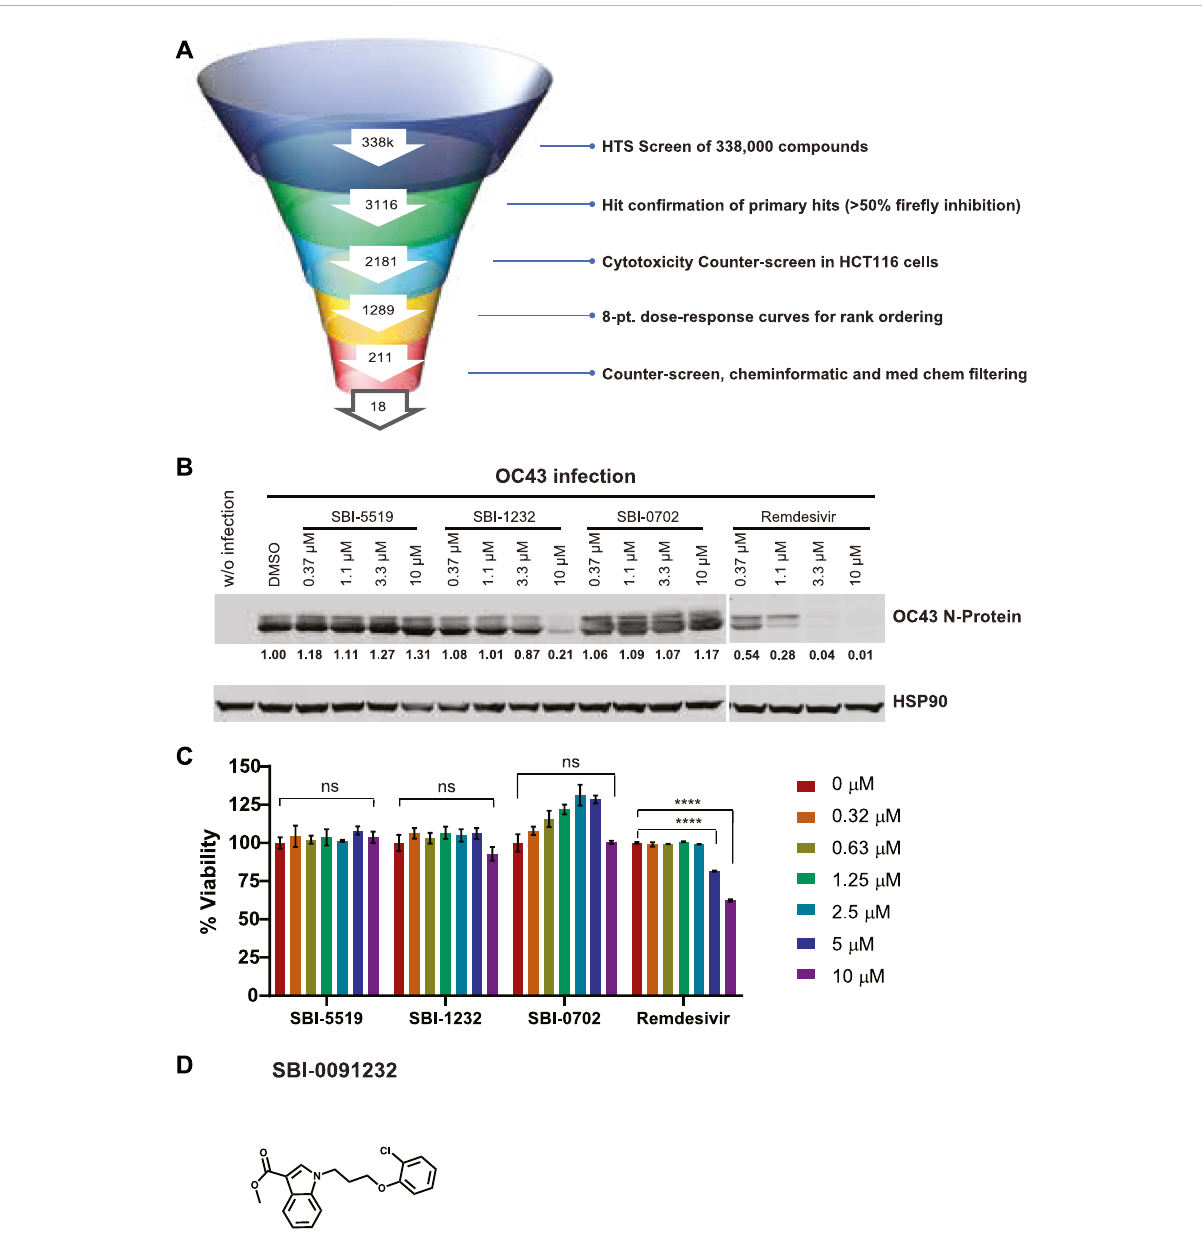
Identi fi cation and validation of OC43 N-protein expression inhibitors. (A) Testing funnel of high-throughput screening campaign. HTS screen performed using fi re fl y (FF) luciferase readout in RRLs using 338,000 compounds. Hits (3116) were selected for CAP-dependent inhibition based on 50% inhibition of the fi re fl y readout, for CAP-dependent inhibition, and further assessed in a cytotoxicity counter-screen using HCT116 cells, excluding compounds promoting nonspeci fi c inhibition of Ren luciferase activity. The resulting 2,181 compounds were subjected to eight points dose-dependent inhibition assessments for effectiveness, which reduced the number of hits to 221. Counter-screens at 5 and 10 mM and additionalchemoinformaticandmedicinalchemistryassessmentledtoselectionof18compounds. (B) Westernblotanalysisofindicatedproteinsin A549 cells. Cells (2 x 105) were infected with OC43 and treated immediately following infection with indicated compounds and concentrations for 24 h. Each protein band was quanti fi ed by ImageJ, normalized to HSP90 levels as indicated blow blots. (C) Viability assay of uninfected A549 cells (8,000 cells/per well) treated with indicated compounds and concentrations. Cell viability was measured 48 h later using CellTiter-Glo. Relative viability was normalized to DMSO-treated control cells. Statistical analysis was performed by one-way ANOVA for the comparison of more than two groups. Data are shown as the mean ± SD, n = 3. * p ≤ 0.05, ** p ≤ 0.01, *** p ≤ 0.001, **** p ≤ 0.0001. (D) Chemical structure of